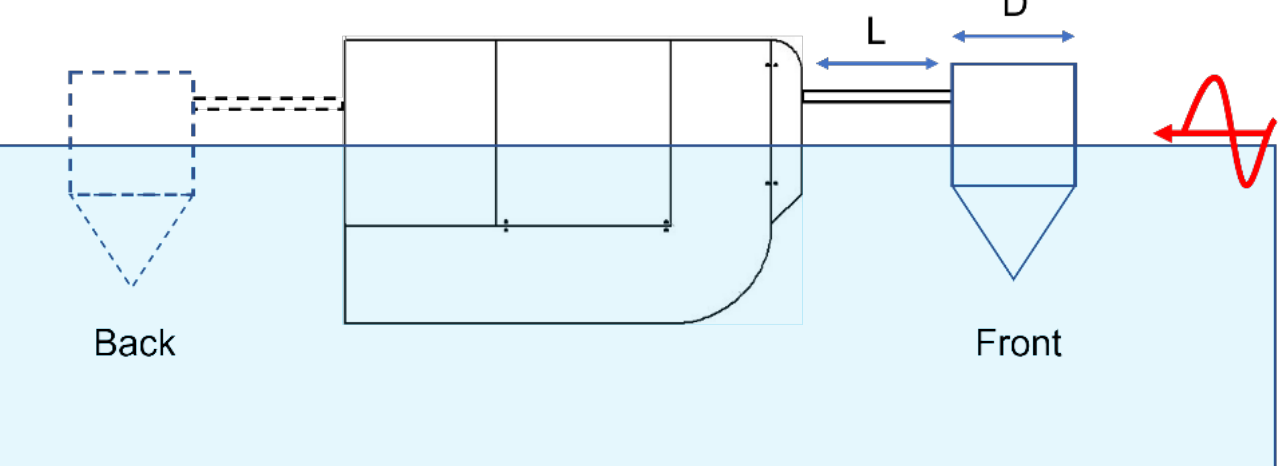
Figure 1. Generic View of Hybrid BBDB-PA System.